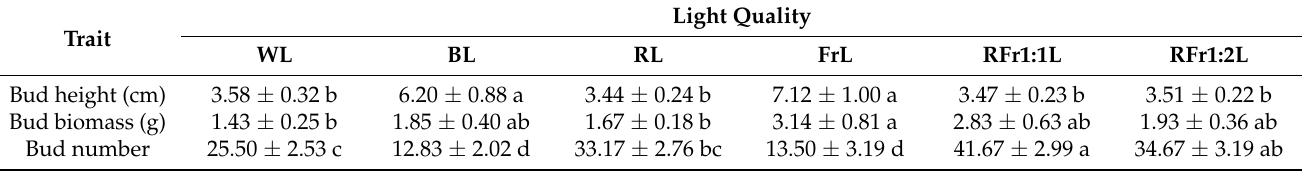
Table 1. Bud growth characteristics of Cunninghamia lanceolata (Lamb.) Hook. under different light quality treatments. Abbreviations for light quality treatments are as described in Figure